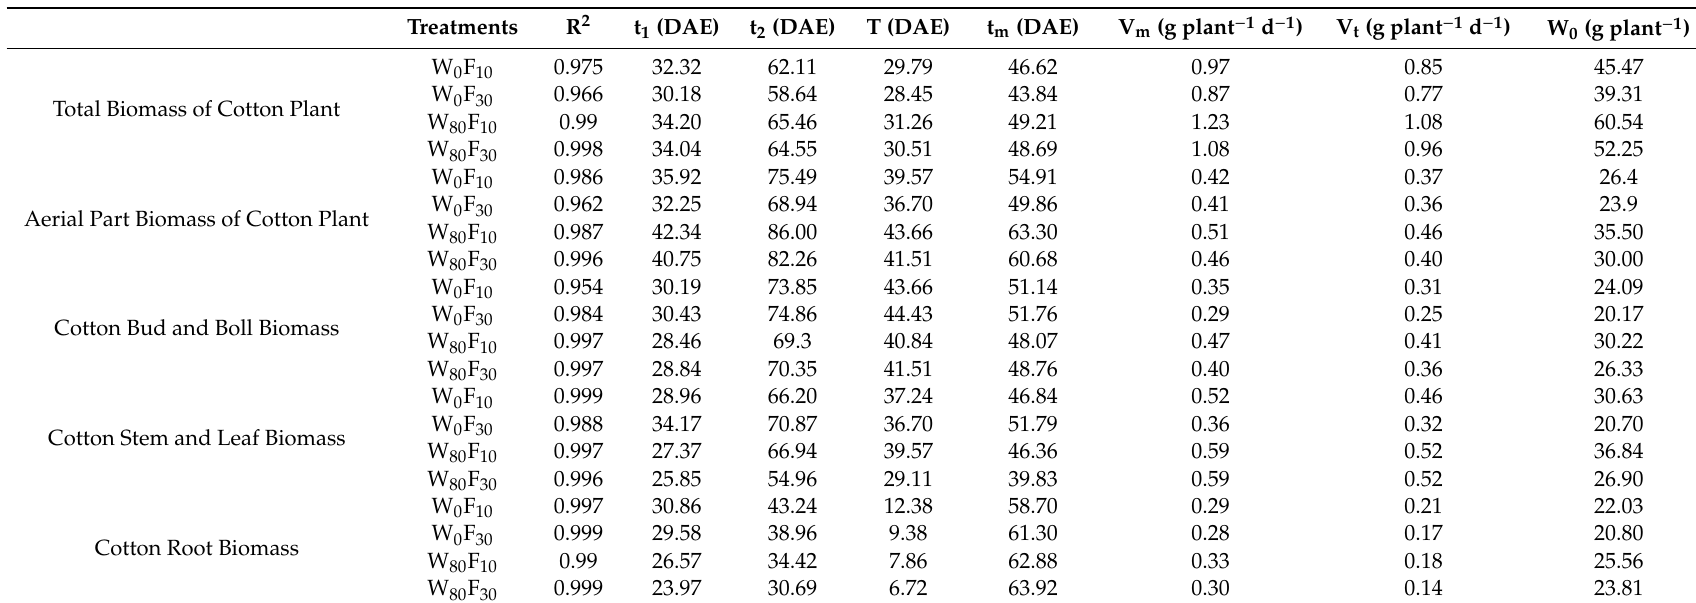
Table 2. Equation of cotton plant biomass accumulation under di ff erent irrigation and fertilization during 2015 and 2016.